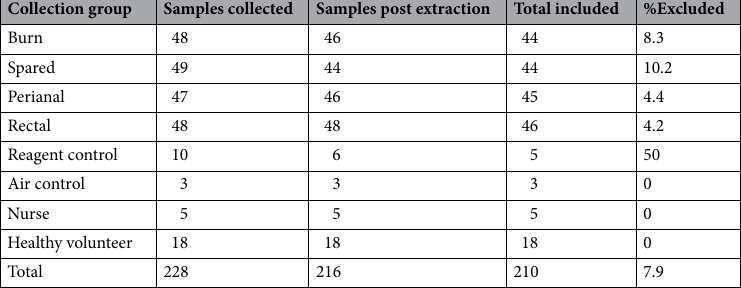
Table 2. Total samples included in